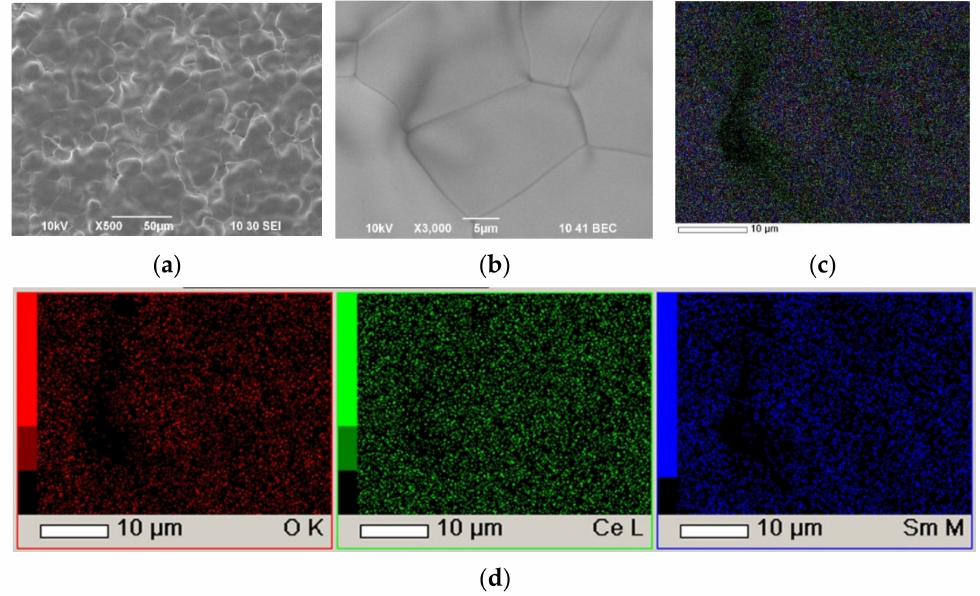
Figure 15. The surface of the SDC electrolyte layer after final sintering at a temperature of 1550 ◦ C for 5 h on a model dense SDC substrate with a platinum sublayer: ( a ) SEM image, magnification × 500; ( b ) SEM image, magnification × 3000; ( c ) integral map of the distribution of elements; ( d ) individual element